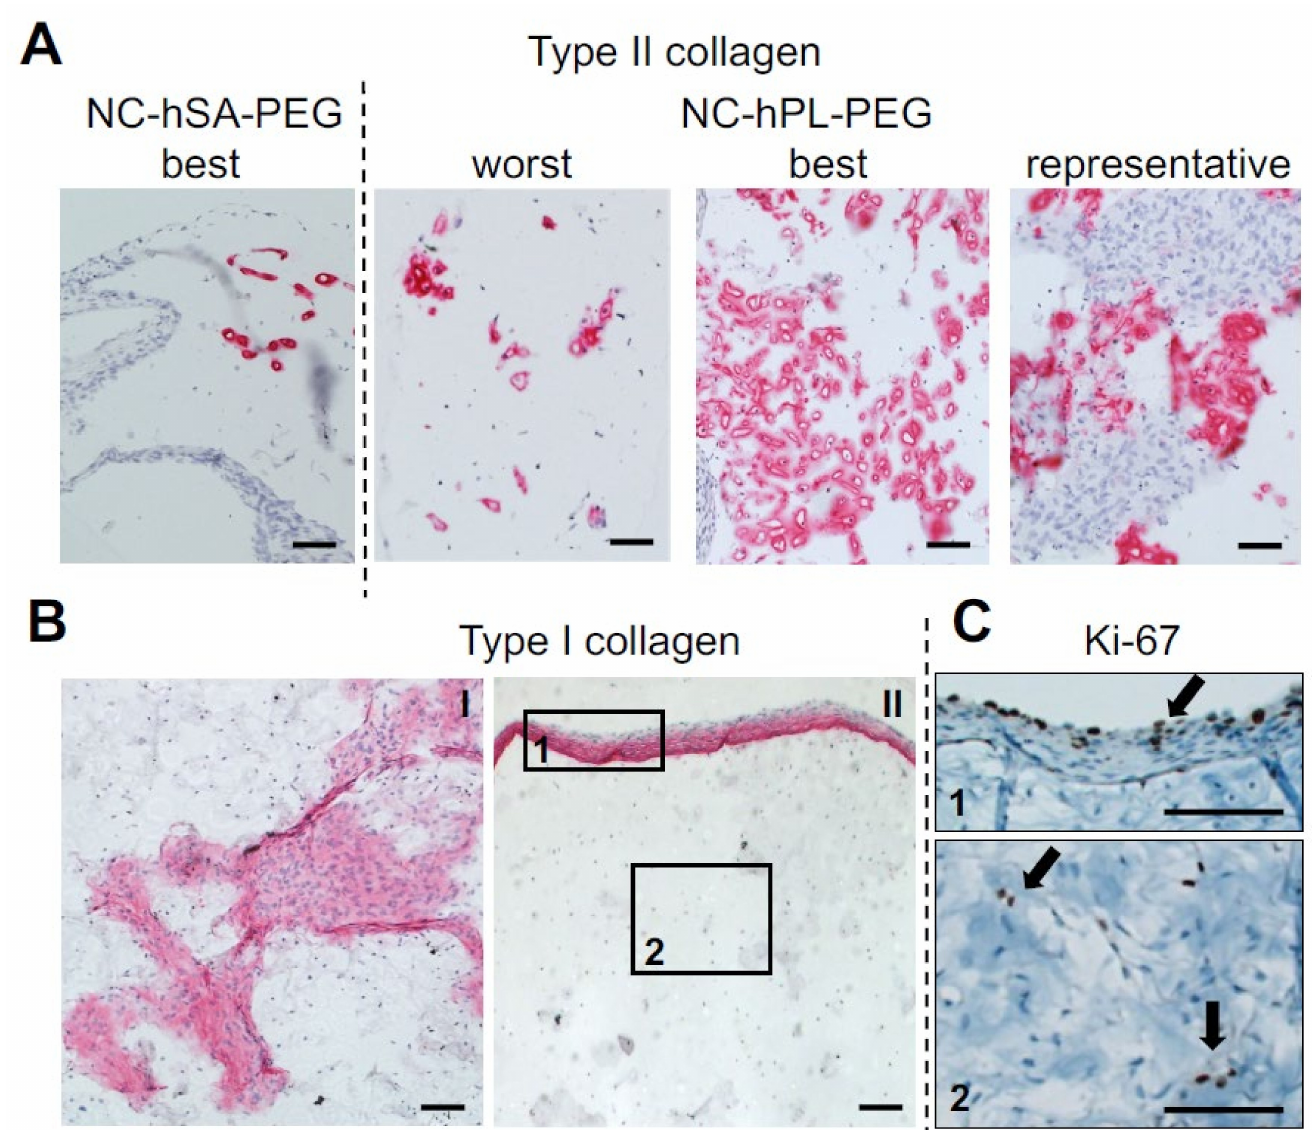
Figure 4. Immunohistochemical characterization of the constructs generated by culturing na- soseptal chondrocytes (NC) in Polyethylene glycol (PEG) gel (NC-PEG). Constructs were gen- erated by culturing rapidly isolated NCs in PEG gel in medium containing human serum albumin (NC-hSA-PEG, control) or platelet lysate (NC-PL-PEG) (see Materials and Methods for details). ( A ) Type II collagen staining of worst, best and representative quality constructs. Scale bar = 100 µ m. ( B ) Type I collagen staining in central (I) and peripheral (II) areas of NC-hPL-PEG constructs. ( C ) Ki-67 staining of NC-hPL-PEG constructs. Images were taken from the same sample as image B/II, of regions (squares) “1” and “2”. Scale bars = 100 µ m. Black arrows indicate Ki-67 positive